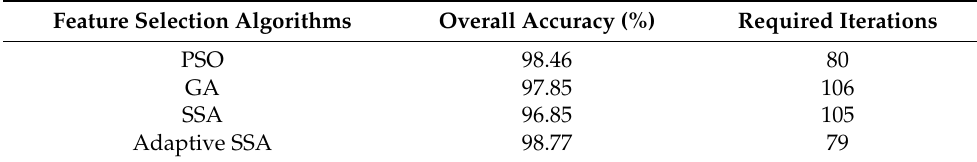
Figure 4. Convergence rate of classification system using different feature selection algorithms. Table 8. Detail of classification performance using different feature selection algorithms.